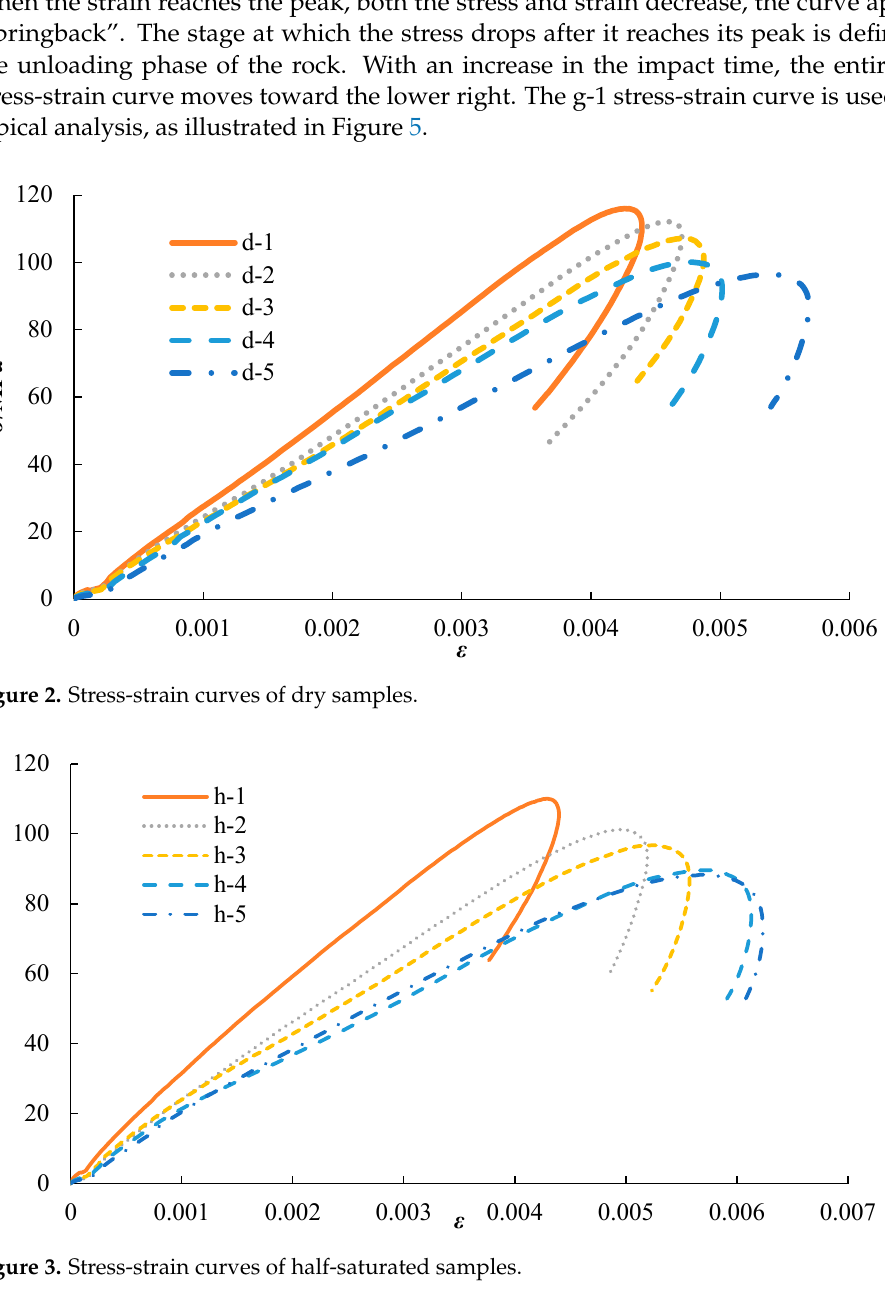
Figure 4. Stress ‐ strain curves of saturated samples.